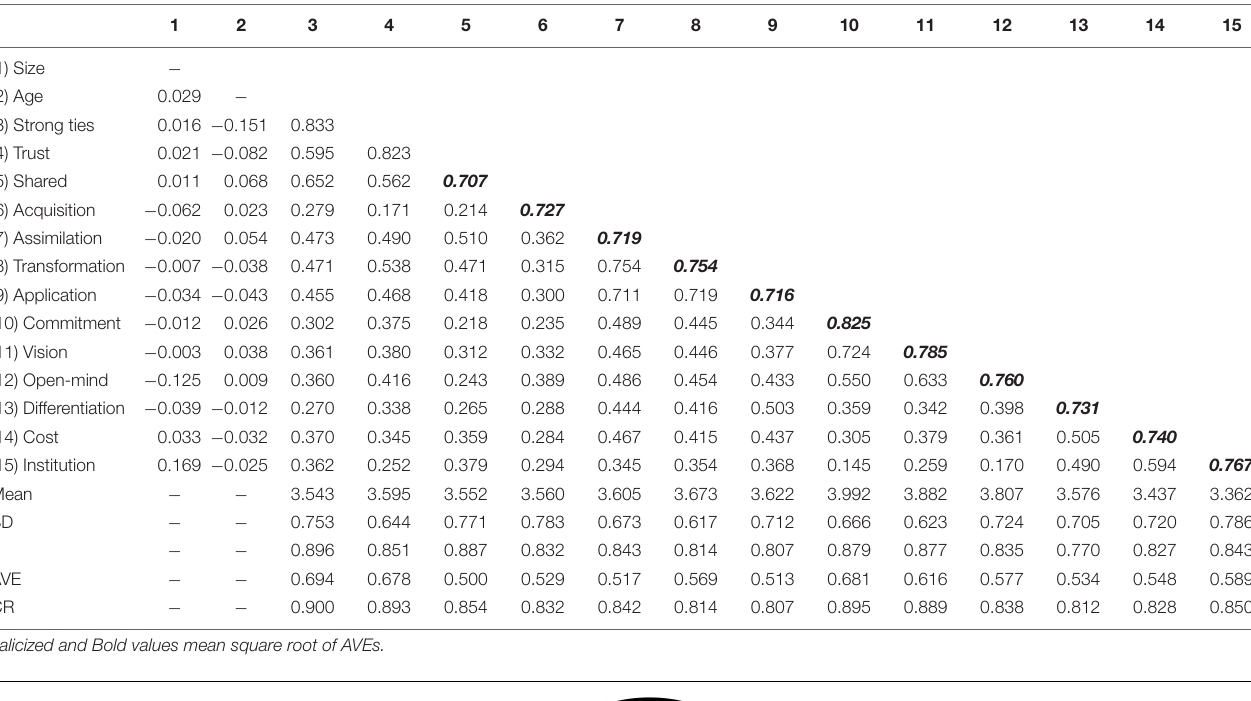
TABLE 2 | Measurement of scales.